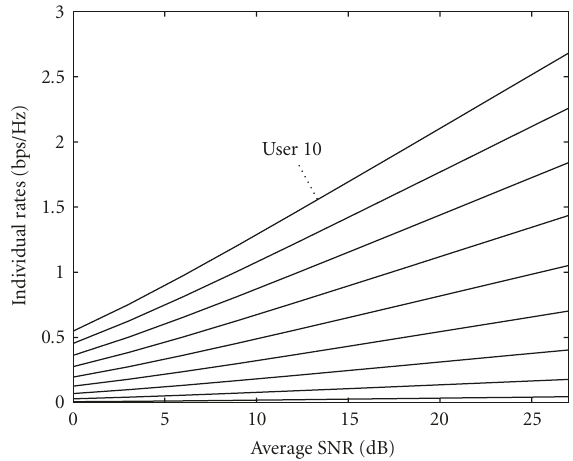
Figure 4: Individual rates for the 10-users channel using ASS.